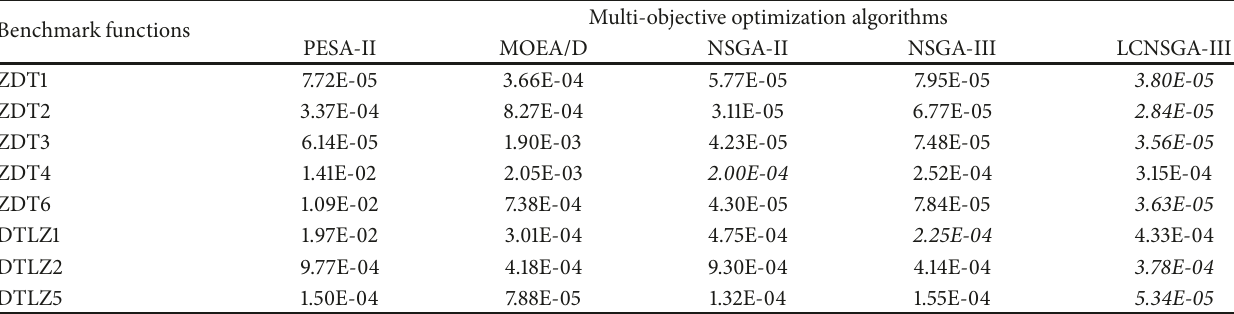
Table 2: Comparison of GD for eight benchmark functions.